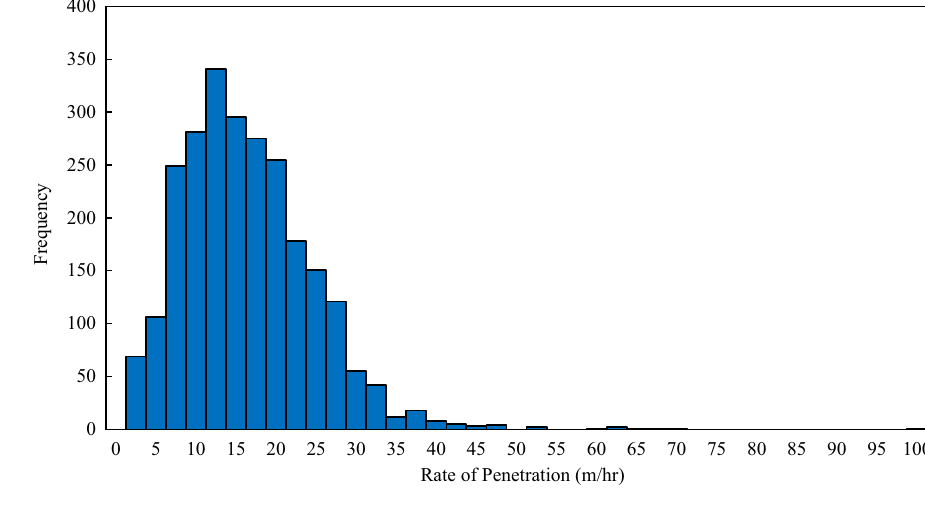
Fig. 3 ROP histogram before filtering (3000 data